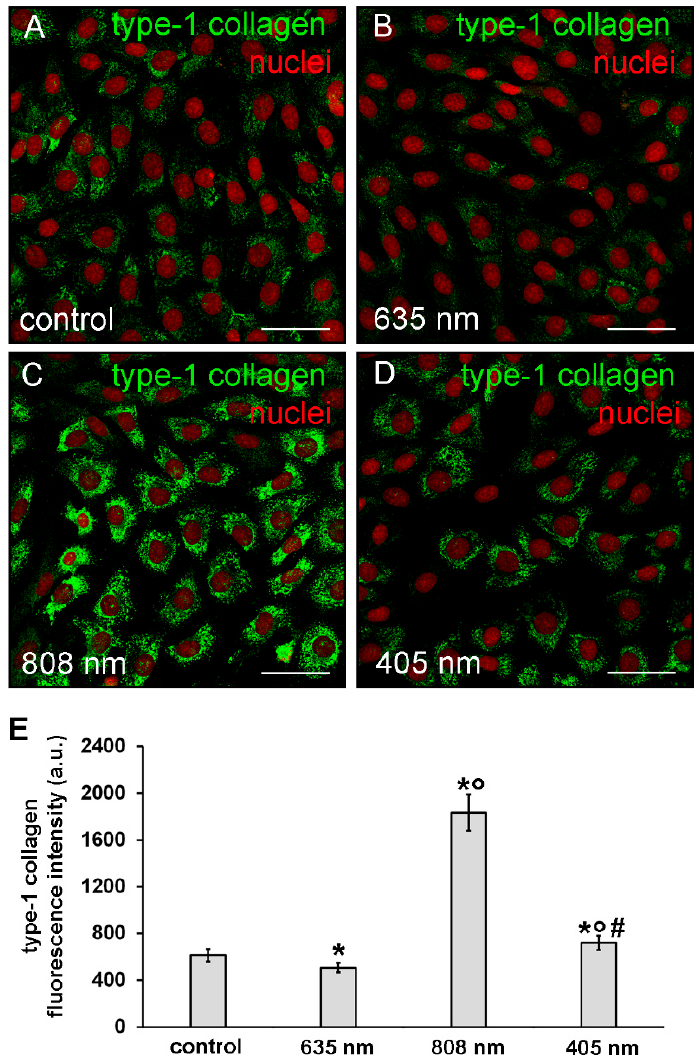
Figure 6. Confocal immunofluorescence analysis of type-1 collagen expression in NIH / 3T3 fibroblasts performed 5 days after cell exposure to red (635 nm), NIR (808 nm) and violet-blue (405 nm) PBM. Cells not subjected to PBM treatments served as control. ( A – D ) Representative confocal fluorescence micrographs of fixed cells immunostained to detect type-1 collagen (green). Nuclei are labeled in red with PI. Scale bar: 50 µ m. ( E ) Histogram showing the densitometric analysis of type-1 collagen fluorescence intensity performed on digitized images. Significance of difference: * p < 0.01 vs. control; ○ p < 0.01 vs. 635 nm; # p < 0.01 vs. 808 nm.